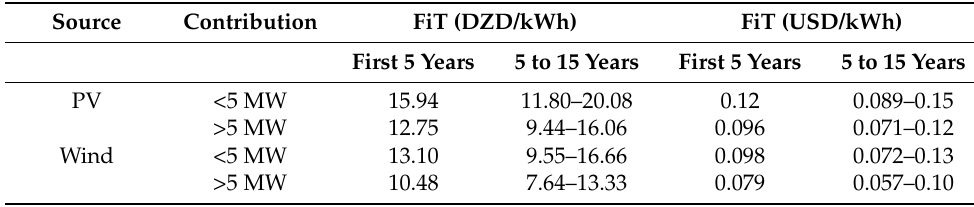
Table 5. Feed-in tariffs (FiT) for RE in Algeria [10,73,75].